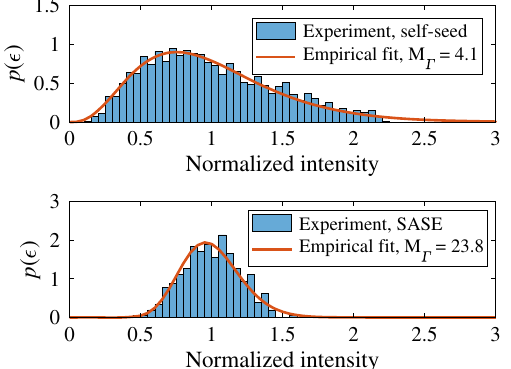
FIG. 13. Histograms of the normalized integrated spectral intensity (blue bars) and empirically derived probability density function (red curves) using Eq. (3) for the experimental measured self-seeding (top) and SASE (bottom) output at U15 with LH 30 μ J.